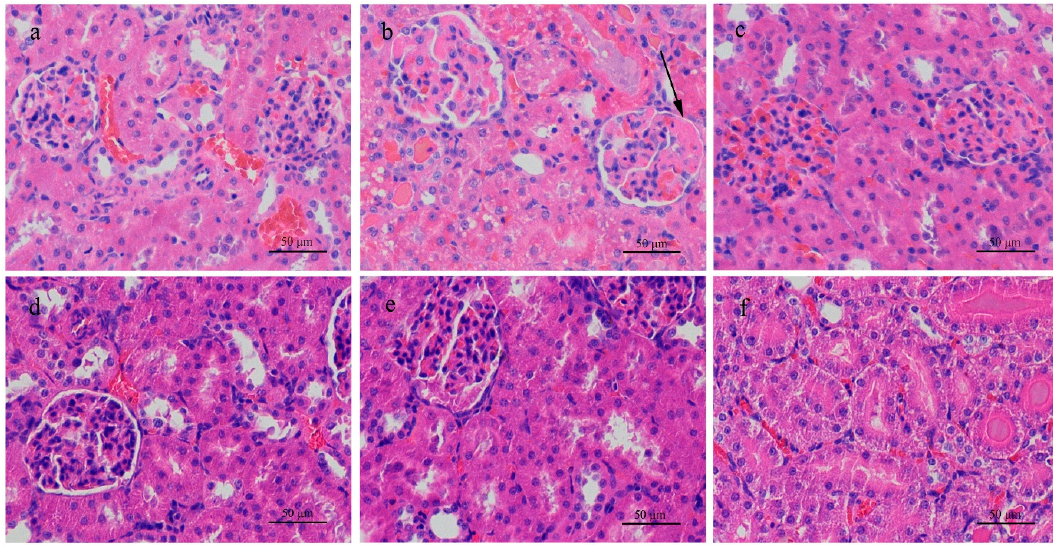
Figure 1. H & E stained histological sections of the kidneys of rats exposed to different concentrations of microcystin-RR (MC-RR) for 24 h. ( a ) 0.0 μ g/kg MC-RR. ( b ) 574.7 μ g/kg MC-RR. Necrosis of glomerular cells (arrow). ( c ) 287.3 μ g/kg MC-RR. ( d ) 50.0 mg/kg DXM mixed with 574.7 μ g/kg MC-RR. ( e ) 10.0 mg/kg DXM mixed with 574.7 μ g/kg MC-RR. ( f ) 2.0 mg/kg DXM mixed with 574.7 μ g/kg MC-RR.